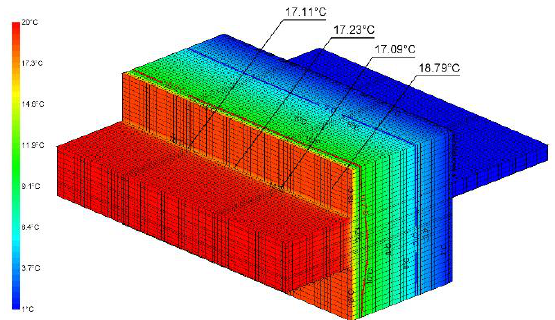
Figure 20. Internal surface temperature distribution field on the wall and deck—top view.